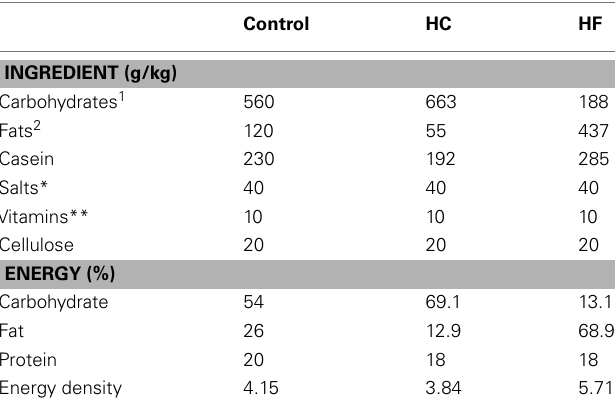
Table 1 | Composition of the control, high-carbohydrate (HC), and high-fat (HF) diets given to the dams during